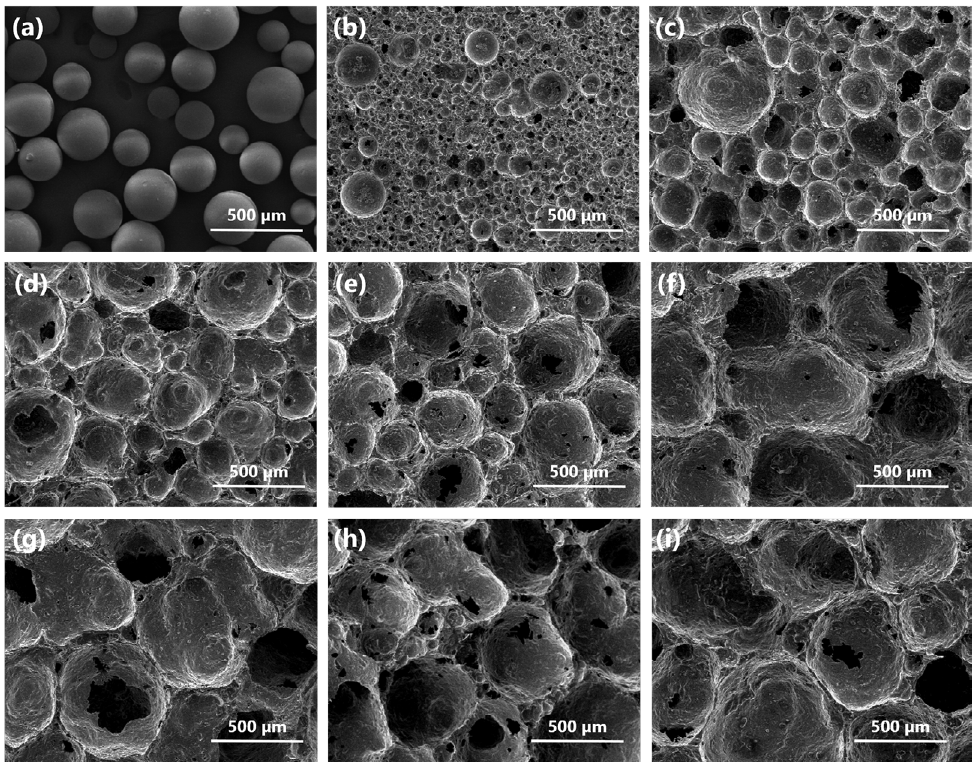
Figure 6. SEM micrographs of the typical morphology and cellular structure of pores formed in vitrocrystalline foams fired at 850 °C for 30 min resulting from different volume fraction of PS spheres incorporation. (a) PS spheres morphology of the depicted in detail. Morphology of glass foams containing: (b) 10; (c) 20; (d) 30; (e) 40; (f) 50; (g) 60; (h) 70 and (i) 80 vol.% of PS. Table 2. Summary of the average pore size distribution and total porosity of vitrocrystalline foams fired at 850 °C for 30 min. Volume fraction of PS spheres (vol.%)